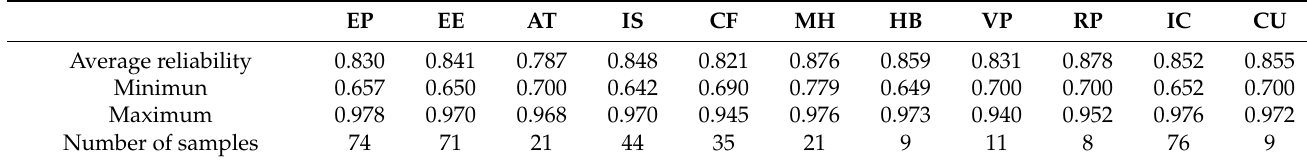
Table 2. Descriptive statistics of the Cronbach’s alpha values stemming from the considered constructs.